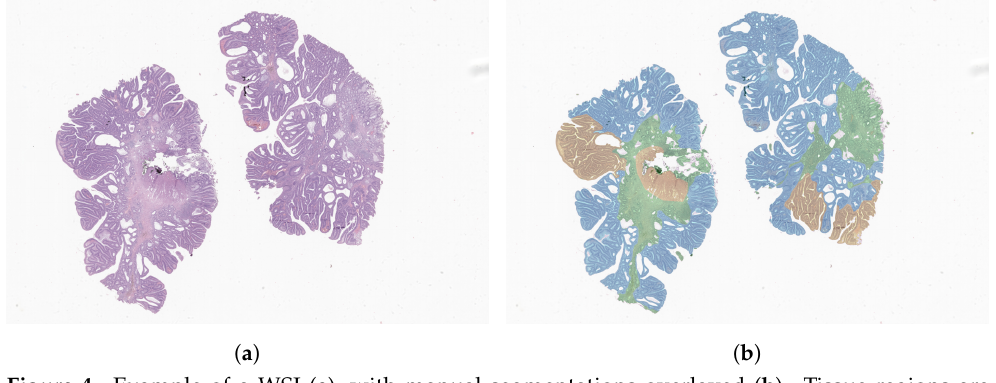
Figure 4. Example of a WSI ( a ), with manual segmentations overlayed ( b ). Tissue regions are annotated as non-neoplastic (green), low-grade (blue) or high-grade (yellow).